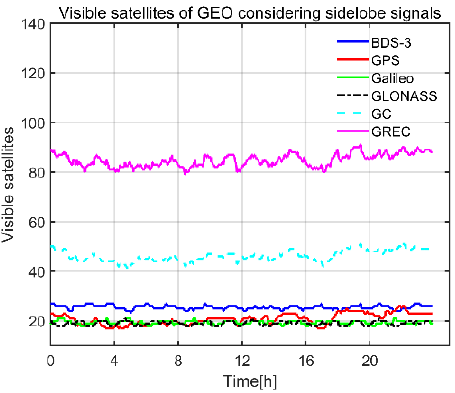
Figure 8. Visible satellites of GEO.